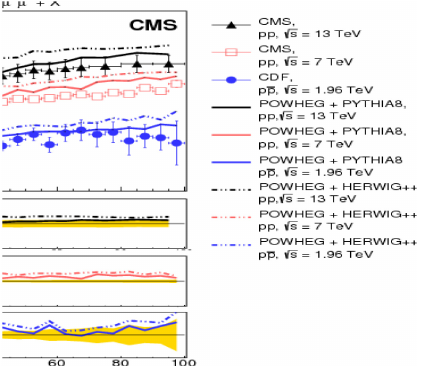
TeV compared with several MC predictions TeV with the measurements at 7 TeV [14] √𝑠𝑠 = 13 √𝑠𝑠 = 13